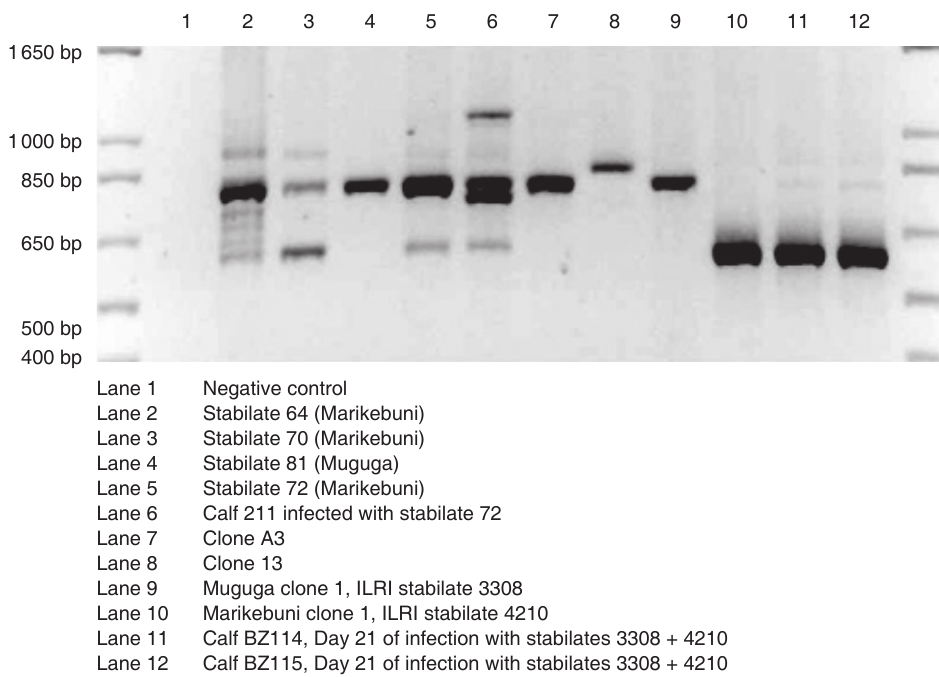
FIG. 1 Polymorphism in PCR size detected within the PIM gene of T.